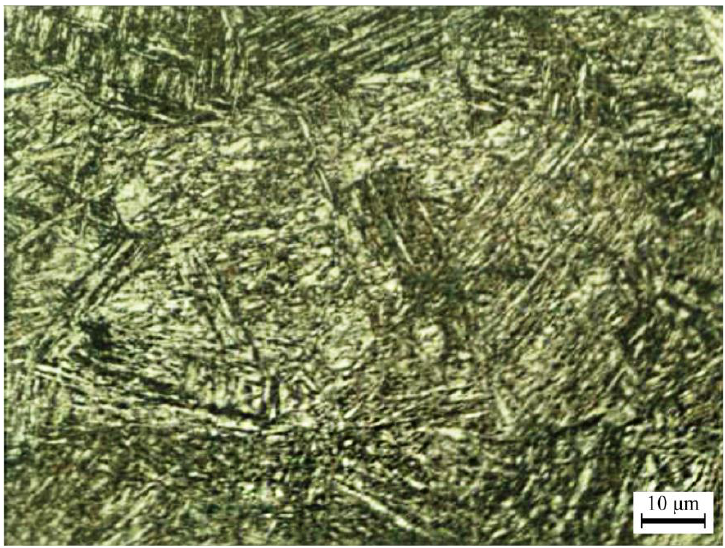
Figure 1. Needle-like microstructure of the AISI 410 martensitic steel. Table 1. Mechanical and fatigue fracture properties of AISI 410 martensitic steel.